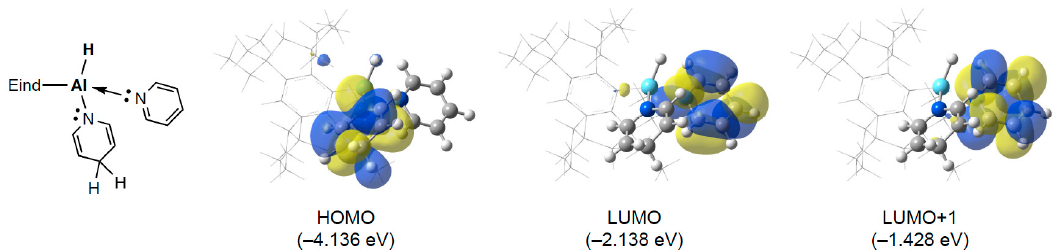
Figure 4. Selected molecular orbitals of 3 together with the energy levels.